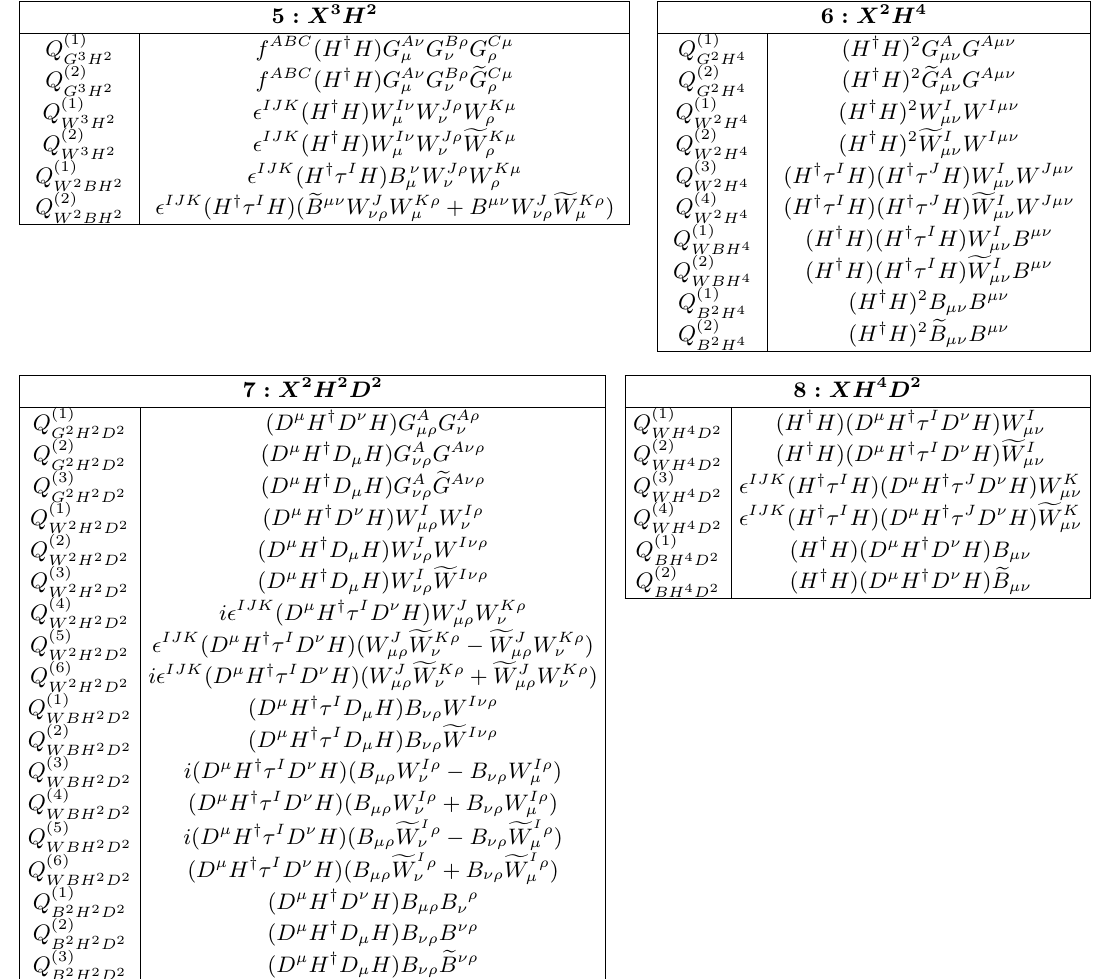
Table 3 . Bosonic dimension-eight operators in the SMEFT containing both gauge (cid:12)eld strengths and Higgs boson